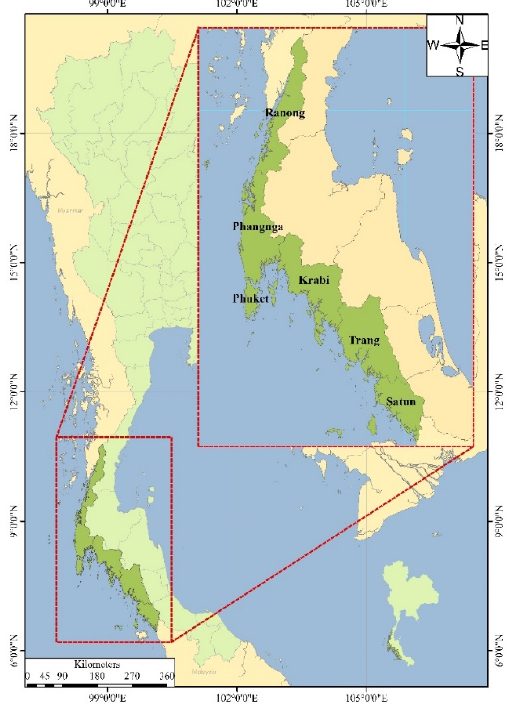
Figure 1. The study area along the coast of the Andaman Sea in Southern Thailand.